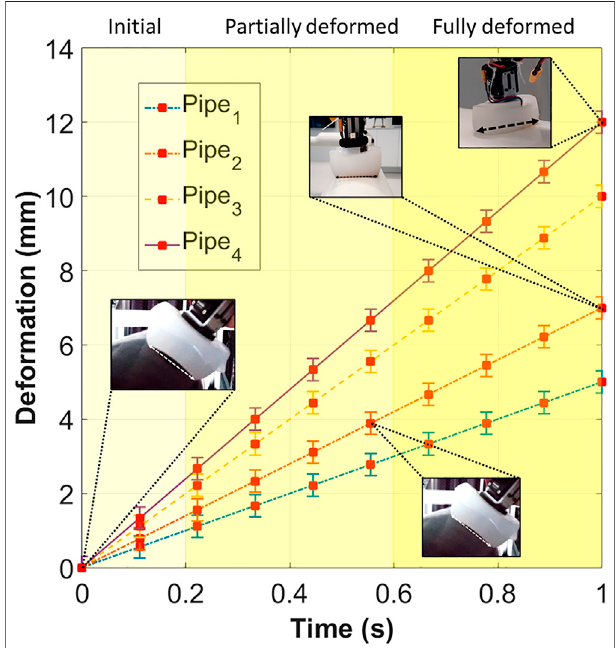
FIGURE 8 | The deformation pro fi le experiment showing the soft toe on different pipes. The soft toe adapts passively while complying with the curvature of the pipe; enabling the robot to crawl on any size of pipe in its current con fi guration. Here the pipes 1,2,3,4 measure 12 (minimum case), 16 (medium case, tested on painted and non-painted pipes), 22 (practical case), and 60 cm (potential case) in diameter, respectively. The change in deformation is proportional to the curvature of a pipe. An increase in the diameter of the pipe results in a corresponding increase in the foot-toe deformation once the robot foot is attached to a metal pipe. The y -axis shows the deformation as displacement, while the x -axis shows the time stamp from a recording which is utilized to observe how the soft toe deforms to the